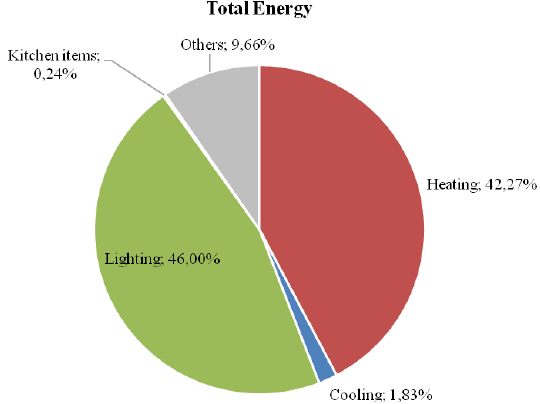
Figure 6. Before-renovation energy consumption of CIPFP Blasco Ibáñez.